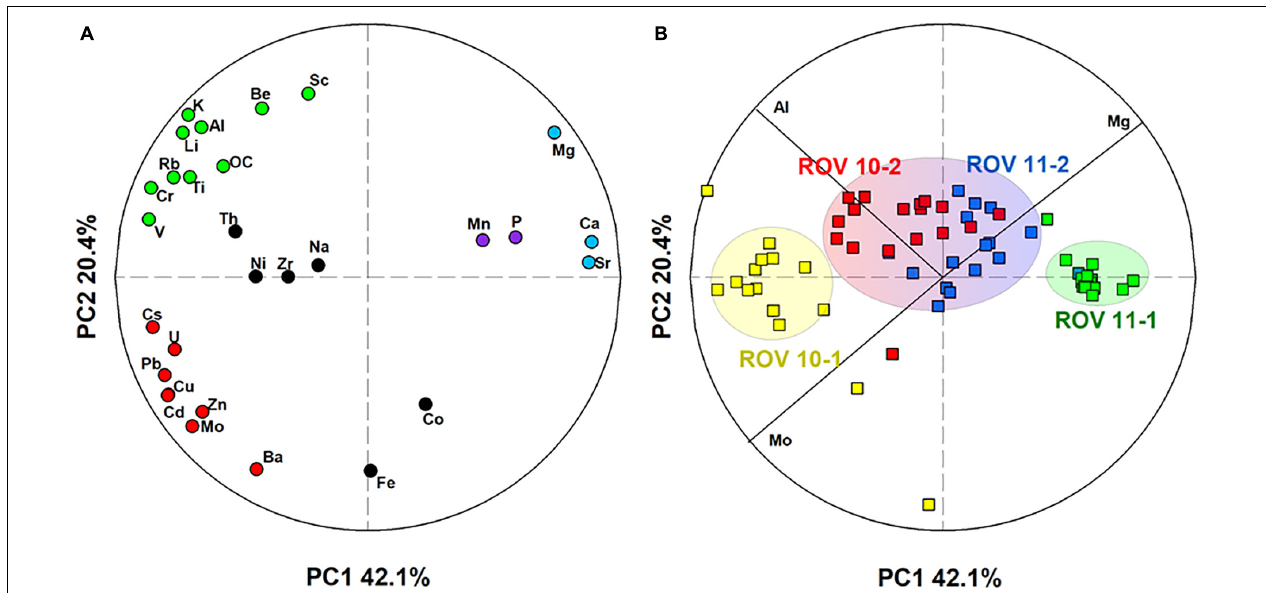
FIGURE 5 | Representation of the two principal components (PCs) obtained by PCA treatment of the dataset including (A) 29 elements and (B) 70 sediment samples. The circles represented the correlation circle. In the left panel, color codes illustrate grouping of elements by their similarities. Three groups of samples were identified in the right